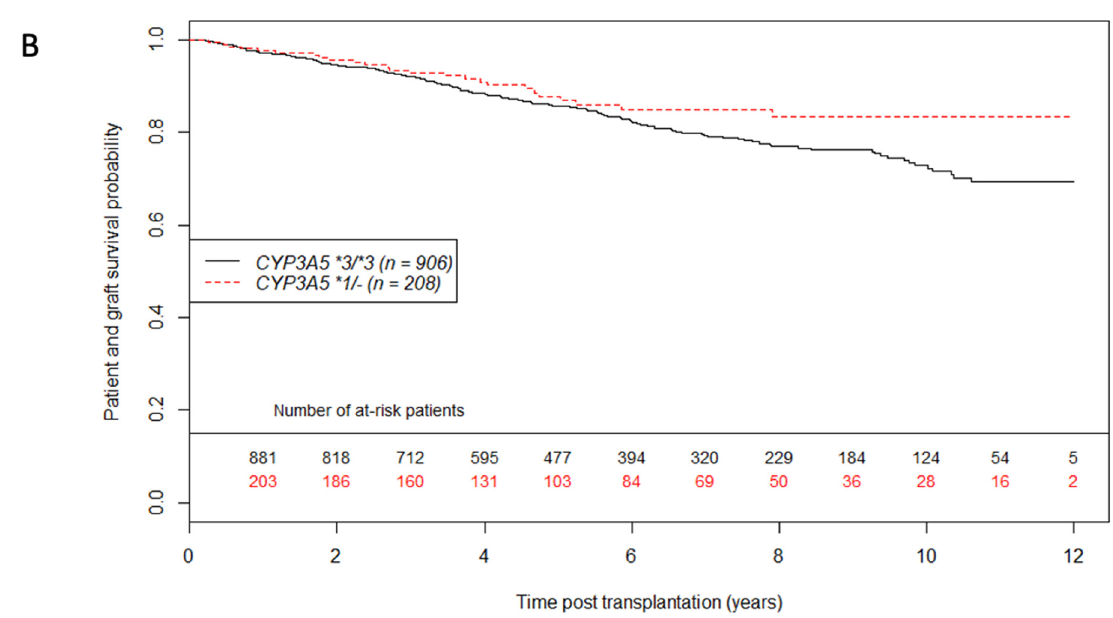
Figure 1. Patient graft survival unadjusted curves using the Kaplan Meier estimator ( A ) on whole population ( A ) and according to CYP3A5 genotype ( B ). Dashed lines represent 95% confidence interval. n = 1114 patients.